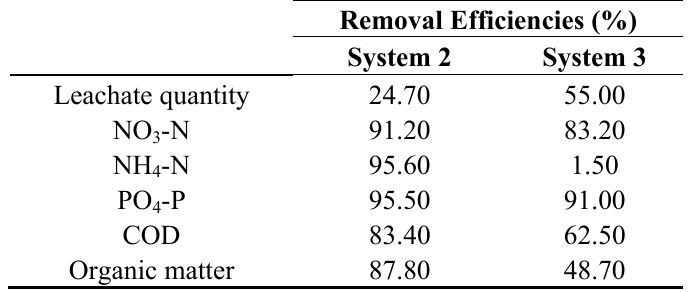
Table 5. Pollutant removal efficiencies in system 2 and system